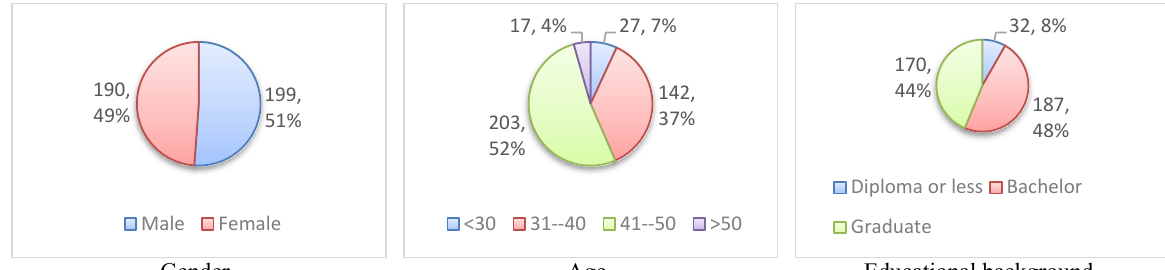
Fig. 1. Personal characteristics of the participants Profile